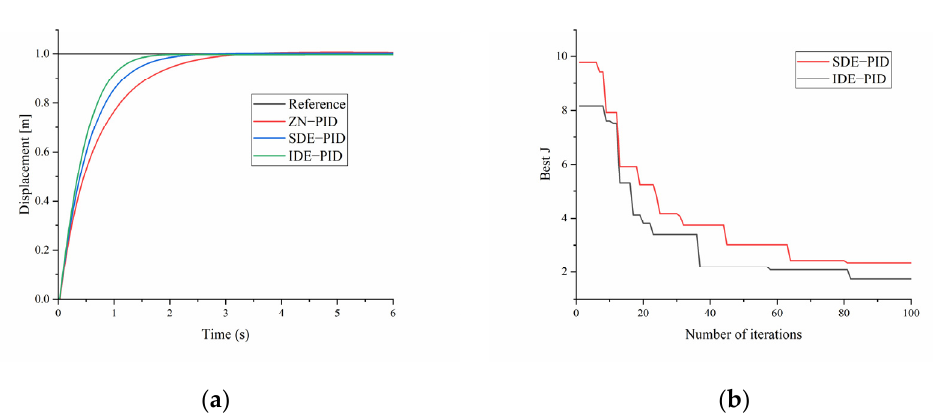
Figure 10. ( a ) Comparisons of step responses and ( b ) convergence curves of SDE-PID and IDE-PID.